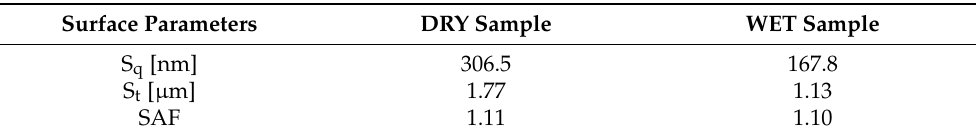
Table 1. Surface parameters (S q , S t and SAF) determined for the 718Plus superalloy oxidized for 120 h in dry and wet air; AFM.